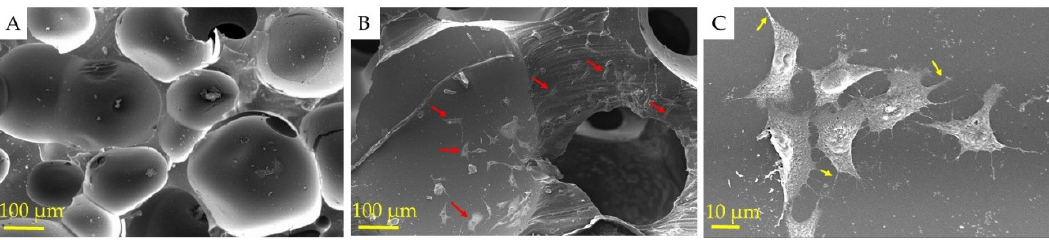
Figure 6. SEM images of the PU-Nl/EEP surface at the ( A ) 1st and ( B ) 7th days after L929 cells seeding. The red arrows indicate the L929 cells. ( C ) SEM images with higher magnification. Yellow arrows indicate L929 cells expanded podocytes.